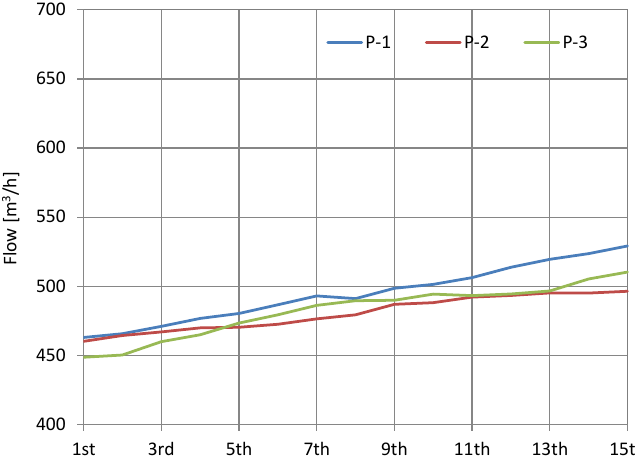
Figure 12. Average annual change in flow rate for cooling water pumps.